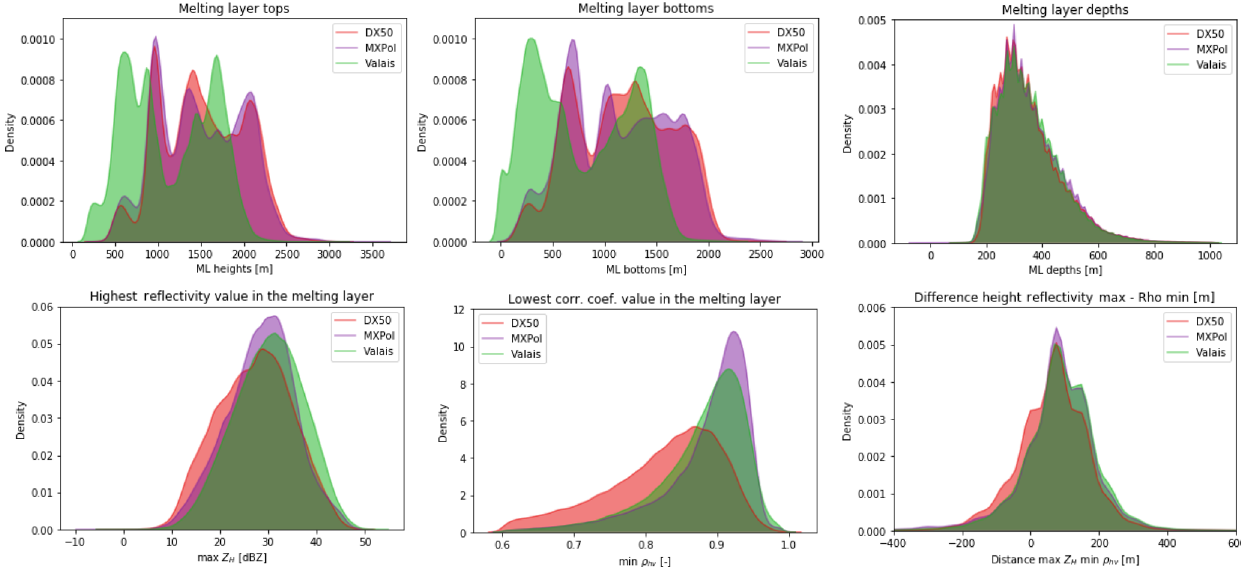
Figure 8. Distributions of the characteristic melting layer